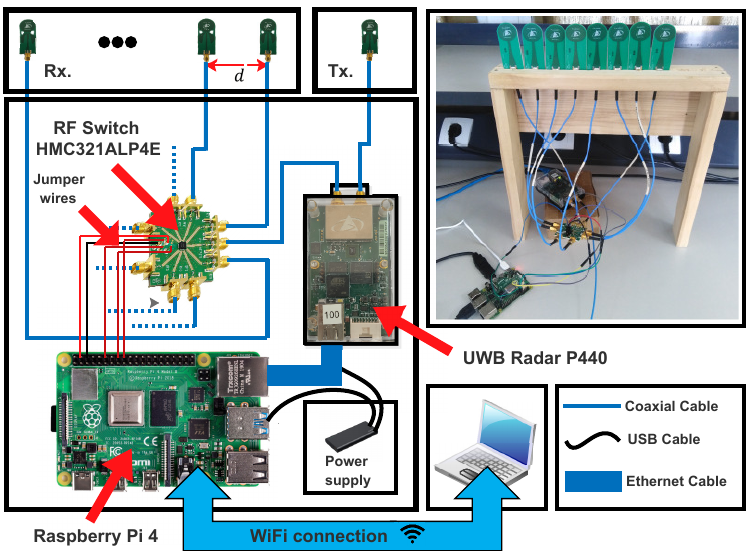
Figure 2. Overview of the SIMO radar-based respiratory measurement system for multiple